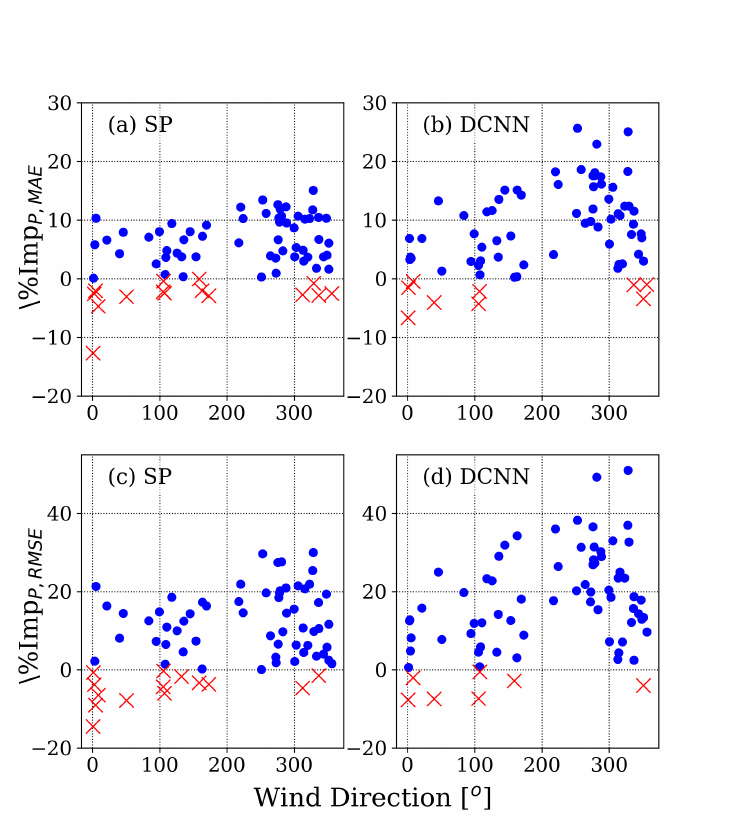
Figure 9. Daily MAE (top) and RMSE (bottom) improvement over persistence as a function of the wind direction for the SP and DCNN models. The blue dots and red crosses represent days where the forecasts outperform the persistence benchmark and vice versa. The wind direction is measured clockwise from True